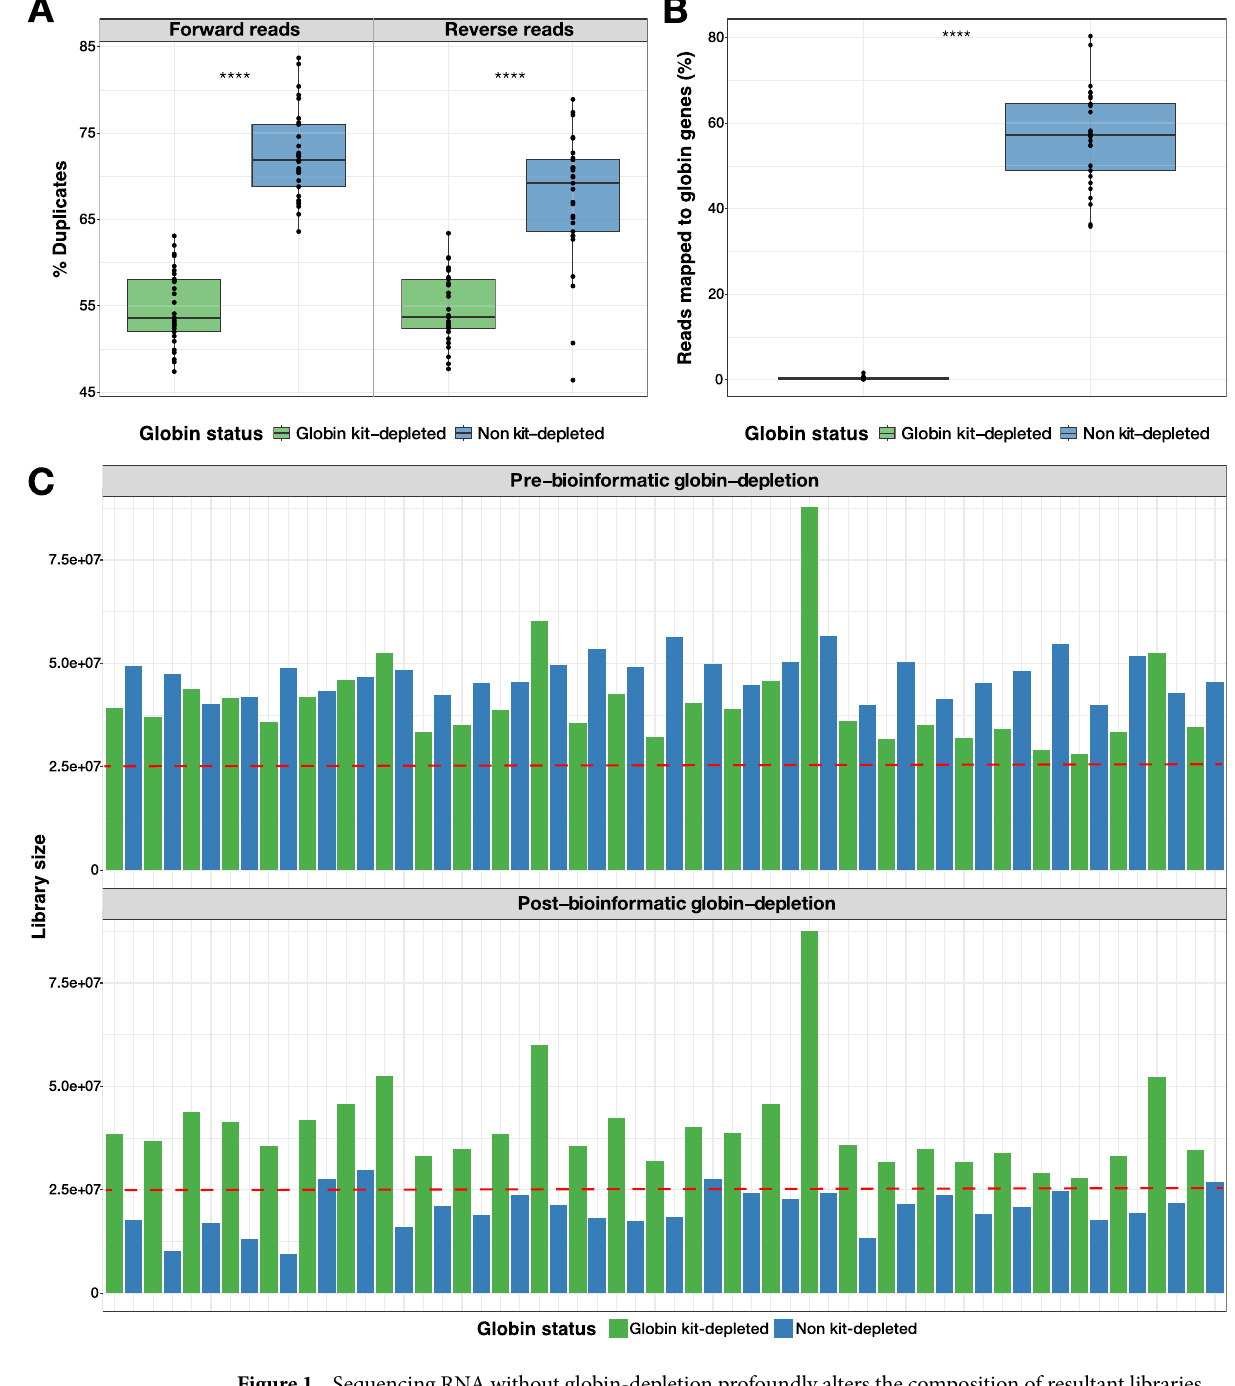
Figure 1. Sequencing RNA without globin-depletion profoundly alters the composition of resultant libraries. (A) Percentage of duplicated reads in forward and reverse reads from globin kit-depleted (green, n = 29) and non-depleted (blue, n = 29) samples. ( B ) Percentage of reads mapping to globin genes. Box plots indicate the median, 1st quartile and 3rd quartile while the whiskers indicate the lower and upper adjacent values. A paired t test was performed to compare each group of samples with and without prior globin depletion and the Bonferroni-corrected p values are displayed; **** p < 0.00005. ( C ) Library sizes for the 29 duplicated samples before (upper panel) and after (lower panel) bioinformatic globin-depletion. The horizontal dashed red line indicates a threshold library size of 2.5 × 10 7 gene